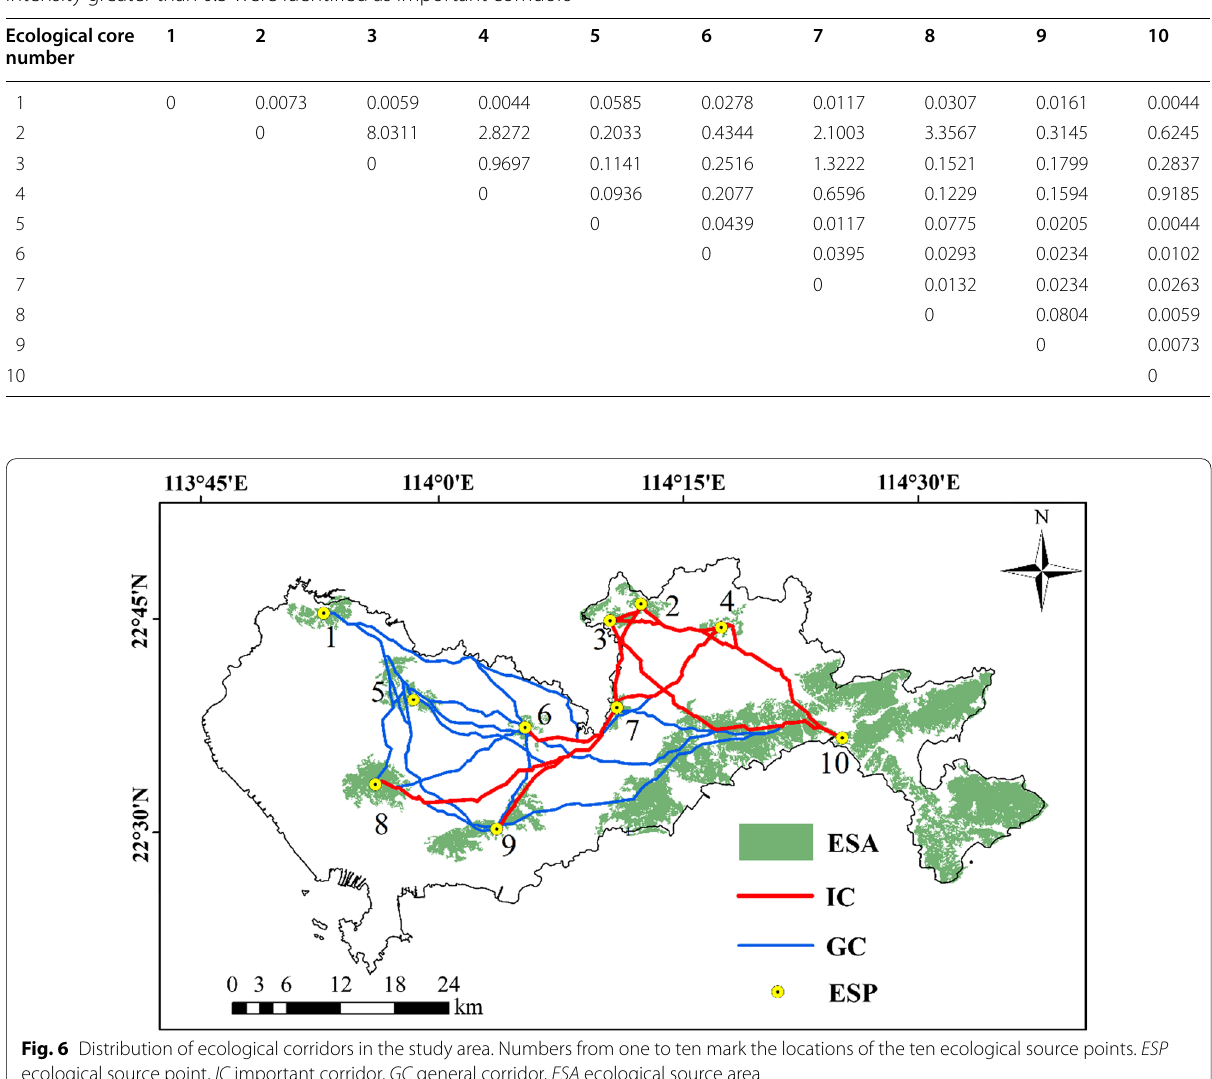
study area (Fig. 7). The analysis of the corridor net- work structure showed that the indices of α , β , and γ all increased compared with the initial results (Addi- tional file 1: Table S2), which indicated that the degree of connection of the ecological sources improved after optimization.